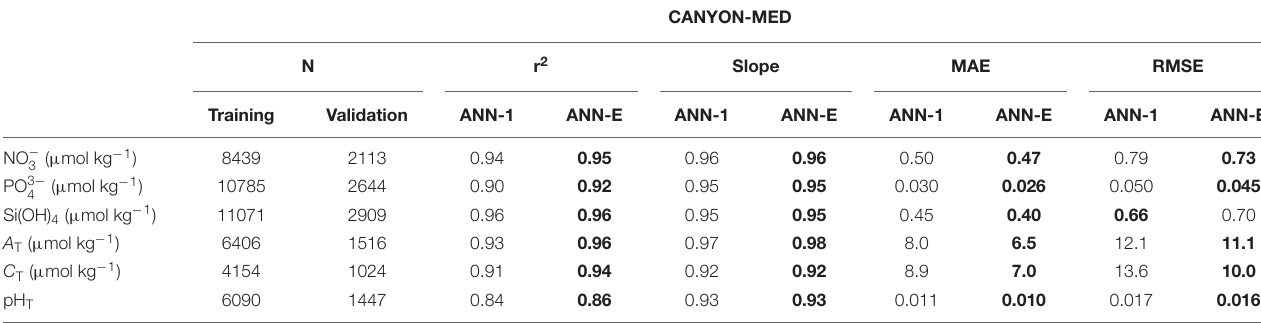
TABLE 2 | Number of points in the training and validation datasets and statistics between in situ measurements from the validation database and the values predicted by CANYON-MED’s “best topology” (ANN-1) and CANYON-MED (ANN-E) for NO − 3 , PO 3 − 4 , Si(OH) 4 , A T , C T and pH T . CANYON-MED N r 2 Slope MAE RMSE Training Validation ANN-1 ANN-E ANN-1 ANN-E